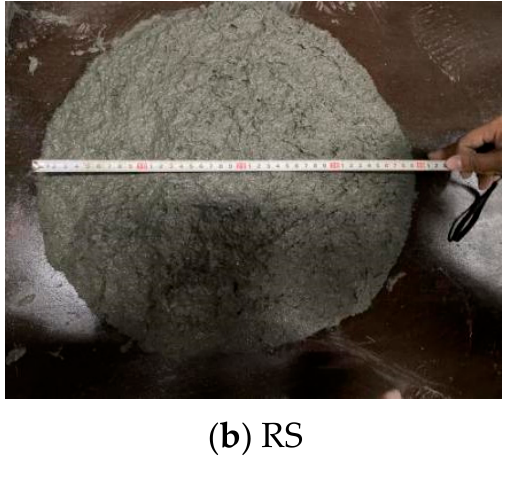
Figure 2. Concrete slump spread test. Table 5. Mixture proportions of UHPC (kg/m 3 ).